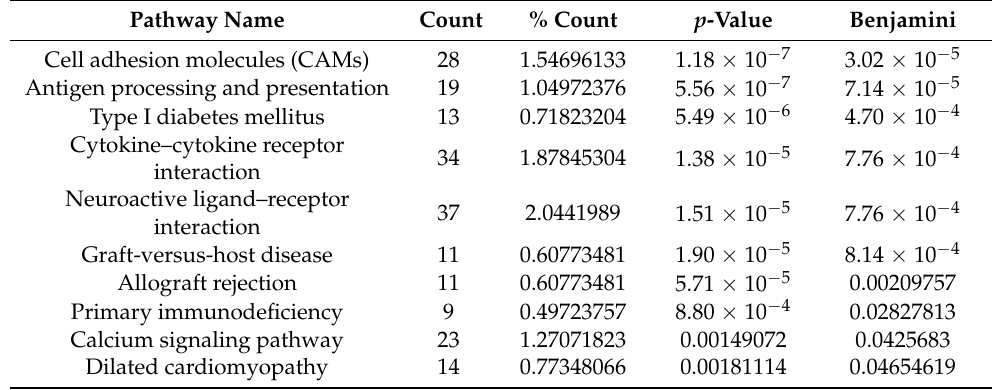
Table 5. K58-R using the Kyoto Encyclopedia of Genes and Genomes (KEGG) analysis; K58-R: fold change ≥ 2 upregulated1897 genes (1810 genes*). * Number of genes corresponds to